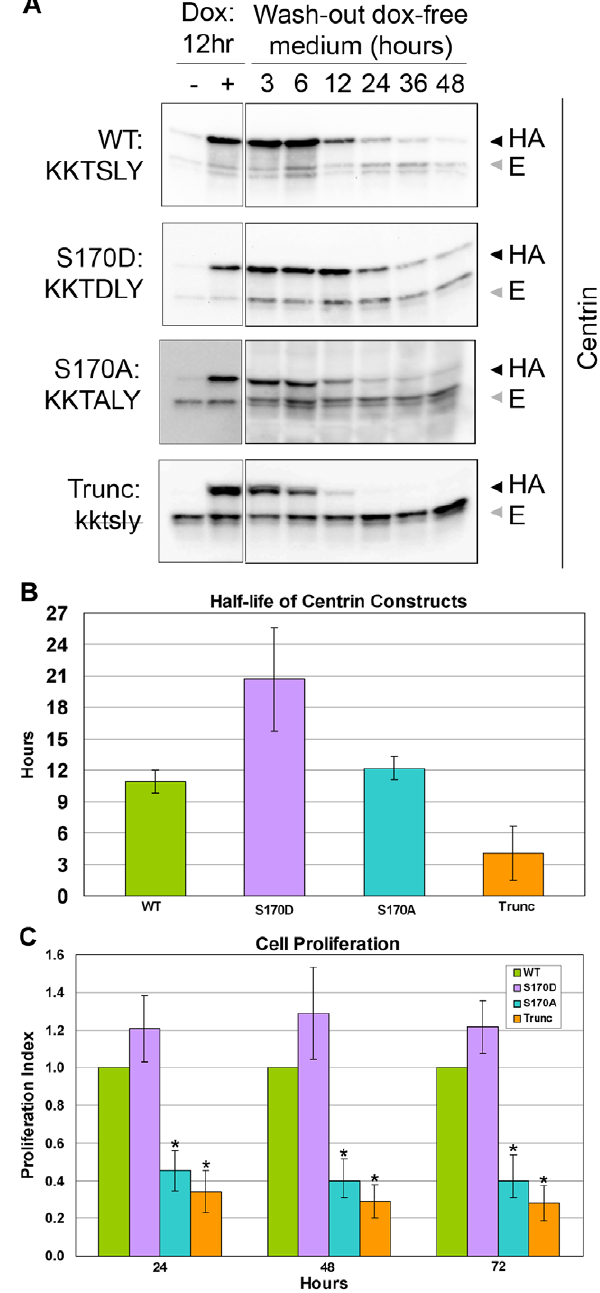
Figure 2. Engineered mutations at S170 affect centrin protein stability and cell proliferation rates in HeLa. (A) Western blotting of whole cell lysates of cells expressing inducible HA-tagged mutant centrin constructs ( b HA) at time points following doxycycline washout reveals that the truncated centrin mutant has the shortest half-life, the S170D mutant that mimics phosphorylated centrin has the longest half- life, while endogenous wildtype centrin ( b E) remains fairly constant. (B) The half-lives of the centrin mutants were determined by plotting the changes in optical density plots of the Western blots shown in (A) for 5 independent experiments. The S170A and wildtype half-lives are virtually the same at 12.2 and 10.9 hr respectively (p=0.942). The S170D half-life, at 20.7 hr, is significantly longer than either S170A or wildtype (p , 0.027 and 0.013, respectively). In 3 of 5 experiments, the half-life of the truncation mutant could not be determined because the time points measured were not early enough. Results of the